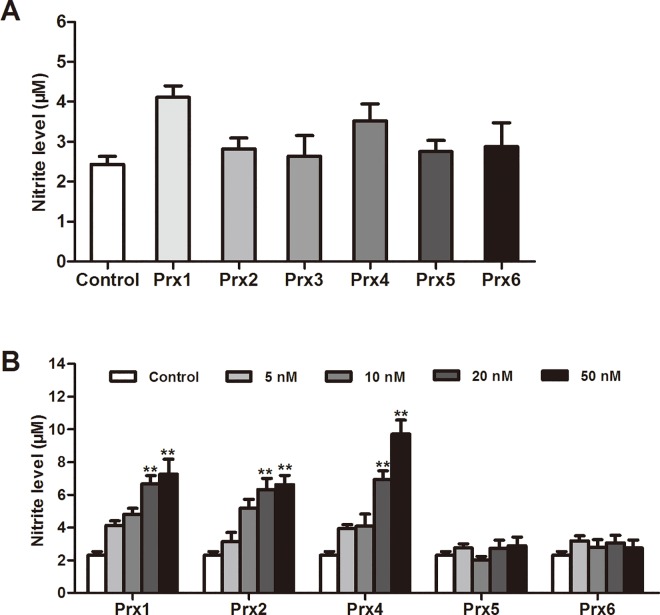
Effects of Prxs on NO production in murine RAW264.7 macrophages.RAW264.7 cells were treated with Prx at the indicated concentrations for 24 h. The content of NO in the culture supernatant was measured using NO assay kit. (A) Effect of 1 nM Prx on NO production. (B) Effects of Prxs at the indicated non-cytotoxic concentrations on NO production. Data are representative of results obtained from three independent experiments with 6 replicates. **P < 0.01 versus control group.